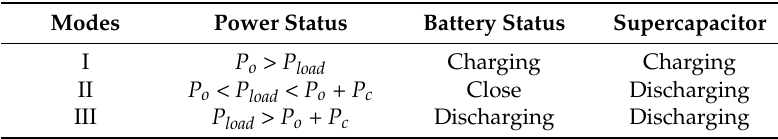
Table 2. Modes of the energy flow.